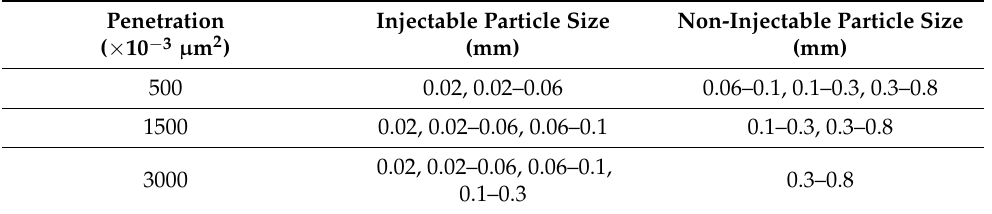
Table 4. Matching relationship between particle size asphalt binder and permeability.